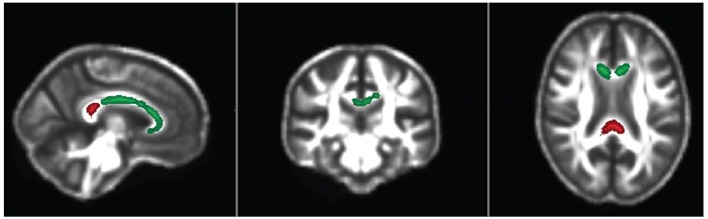
Axial, coronal and sagittal views of significant regions (FWE p < 0.05) in the corpuscallosum where baseline Axial Diffusivity (Green; Sit-to-stand test) and Mean Diffusivity (Red; TUG test) associated with physical fitness improvement or decline over 24 months.